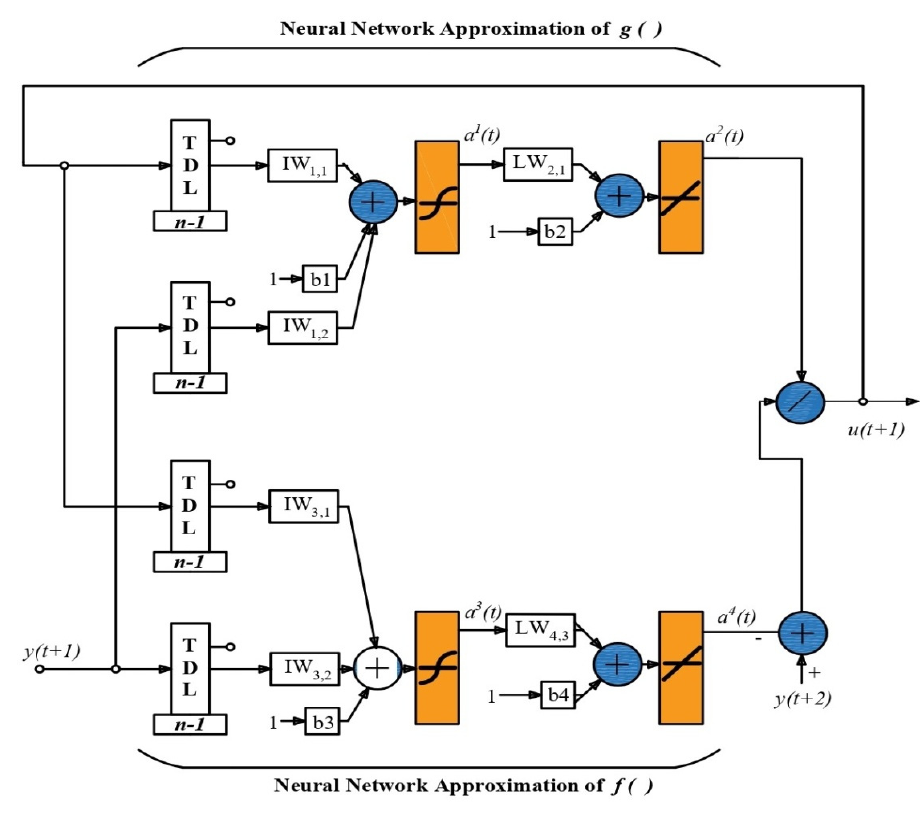
Figure 6. NARMA-L2 with the neural network model.